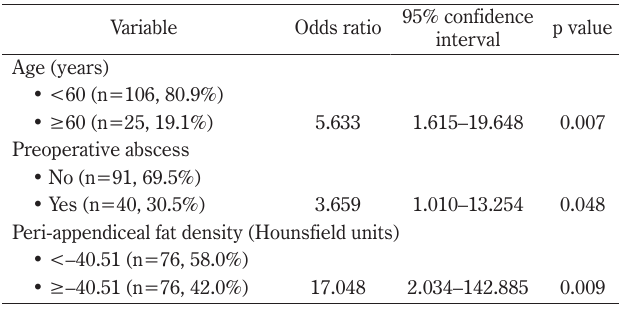
Table 3 Multivariate analysis of the preoperative variables to determine the risk factors for conversion Variable